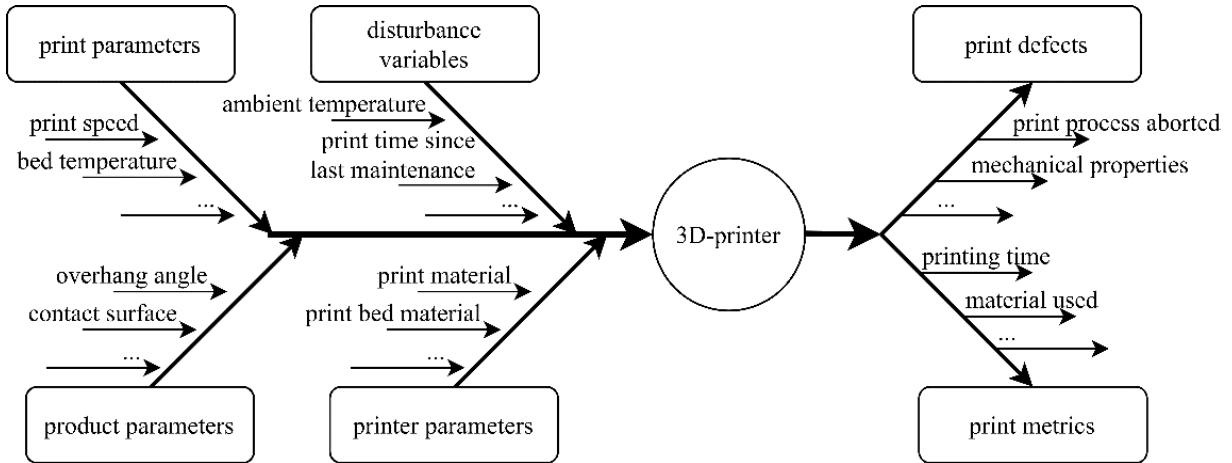
Figure 7. Extended Ishikawa diagram visualizing all relevant input and output parameters for the proposed method from a 3D-printed product in FFF.